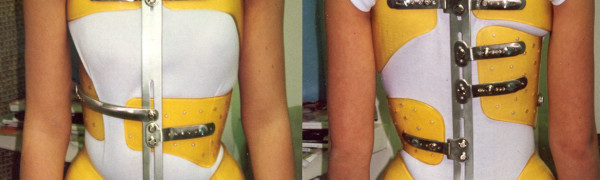
Thoracic main shell.